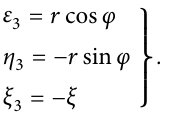
Figure 4: Coordinate transformation diagram: (a) Coordinate system ε